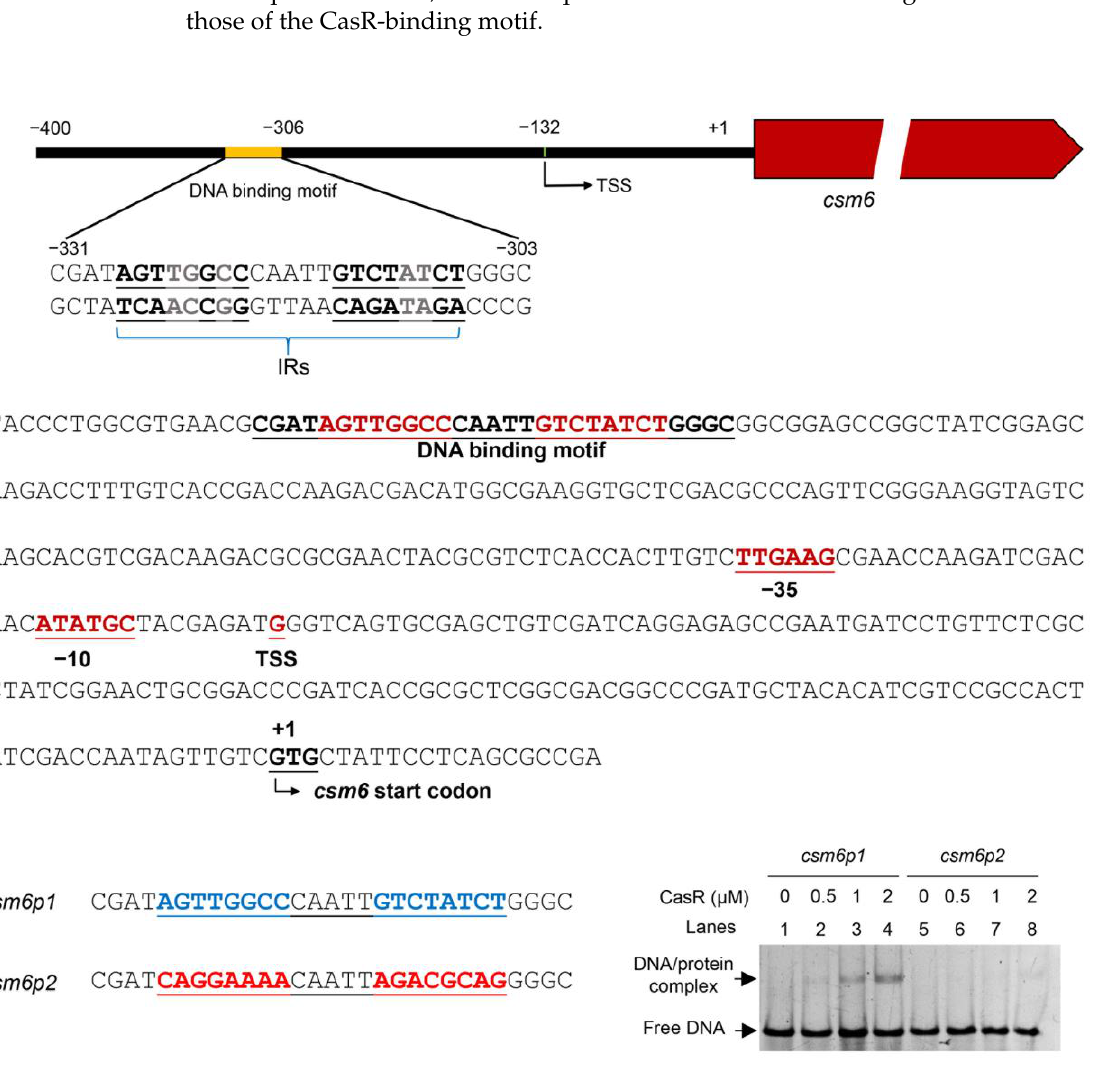
Figure 5. Motif of CasR-binding csm6 promoter. ( A ) Sequence and structural characterization of CasR-protected csm6 promoter region. The CasR- protected regions from −331 to −306 are indicated with underlines. Putative −10 and −35 sequences are marked. The approximate transcription start site at position −132 is marked with TSS. ( B ) EMSA of DNA-binding activity of CasR on the DNA probes, with ( csm6p1 , Lanes 1 – 4) or without IR sequence ( csm6p2 , Lanes 5 – 8). Either DNA probe was co-incubated with 0 –2 μM CasR protein.